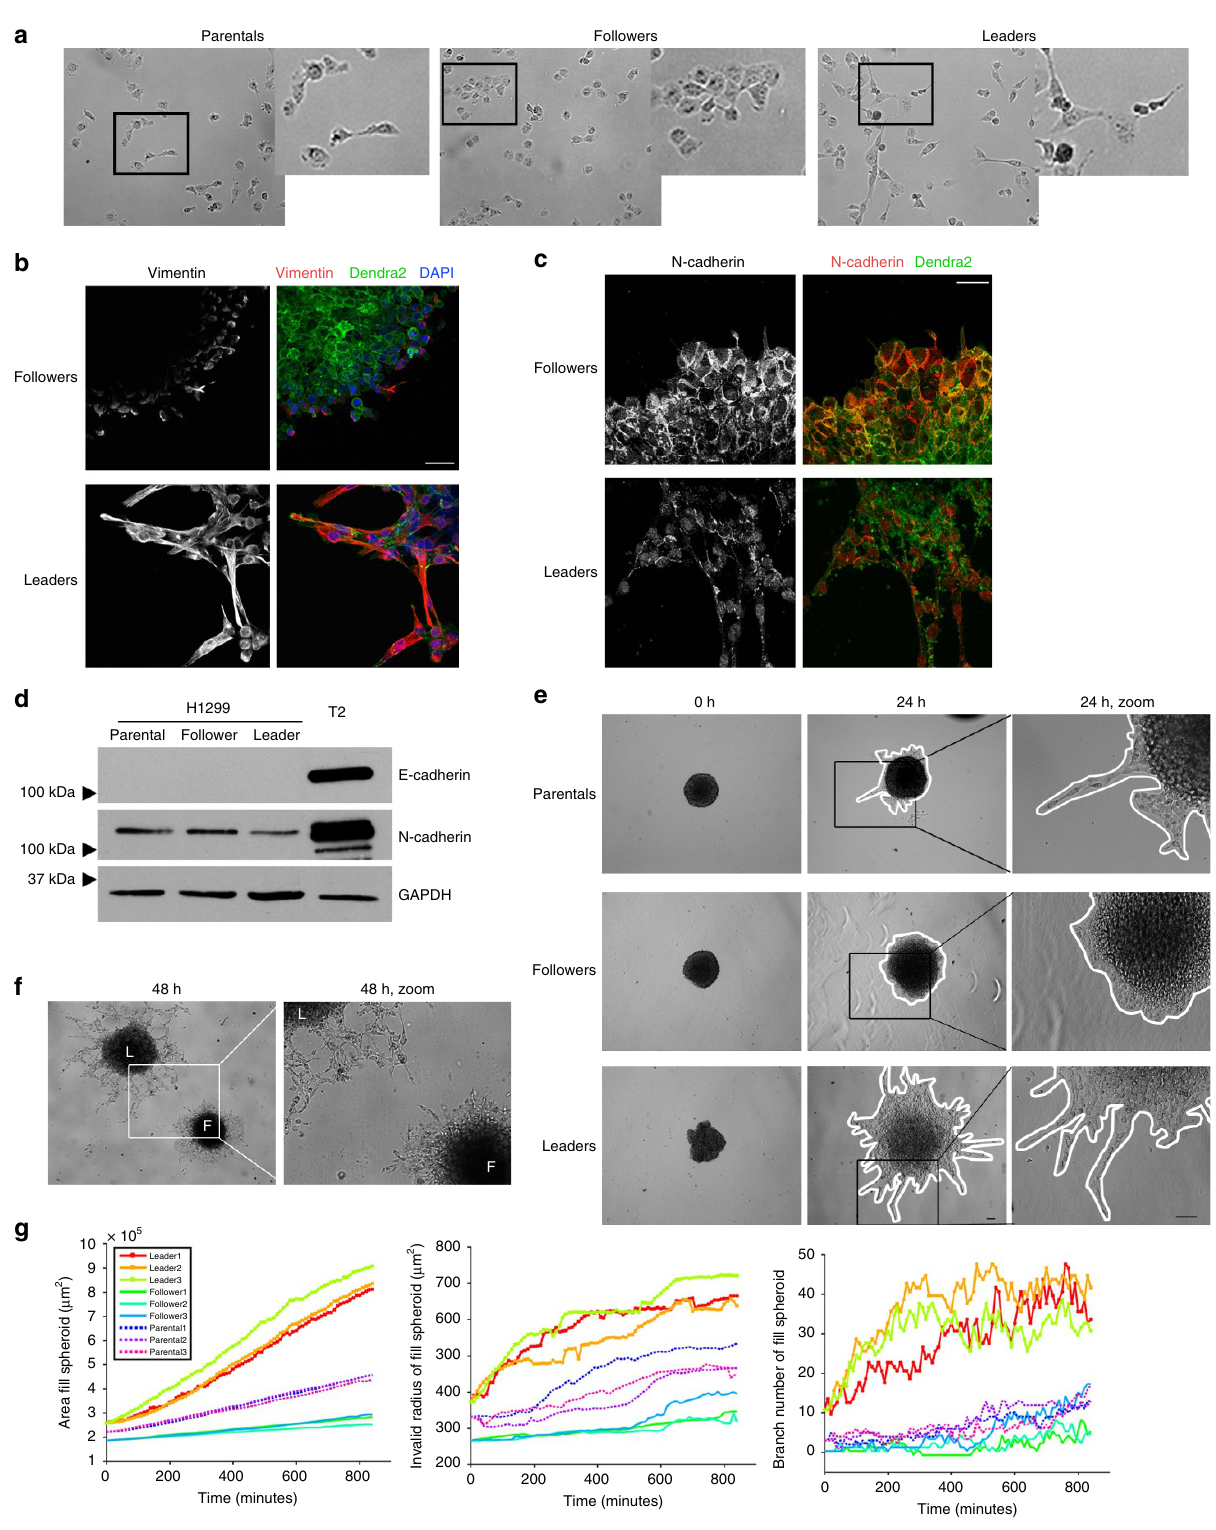
Figure 2 | Leader cells maintain their invasive phenotype even while cultured as a purified population. ( a ) Images of H1299 follower and leader purified cells compared to the parental line. Zoomed images are shown to the right. ( b ) Immunofluorescence staining of vimentin (red) in follower and leader purified spheroids. Scale bar, 50 m m. ( c ) Immunofluorescence imaging of N-cadherin in purified leader and follower spheroids. Scale bar, 50 m m. ( d ) Western blot of H1299 parental, follower and leader cells for E-cadherin and N-cadherin. The T2 mouse tumor-derived cells are a positive control for E-cadherin. GAPDH as a loading control. ( e ) Spheroid invasion assays comparing H1299 parental, follower and leader spheroids. Zoomed images are on the right. Scale bar, 50 m m. ( f ) Leader (L) and follower (F) spheroids were embedded in proximity to each other in the same matrix. Images were taken at 48h post embedding, with a zoomed image to the right. ( g ) H1299 parental, follower and leader spheroids were imaged using live cell confocal microscopy. Fluorescence images in both time and z were analysed for area, invasive radius and branch number. Three spheroids were analysed per